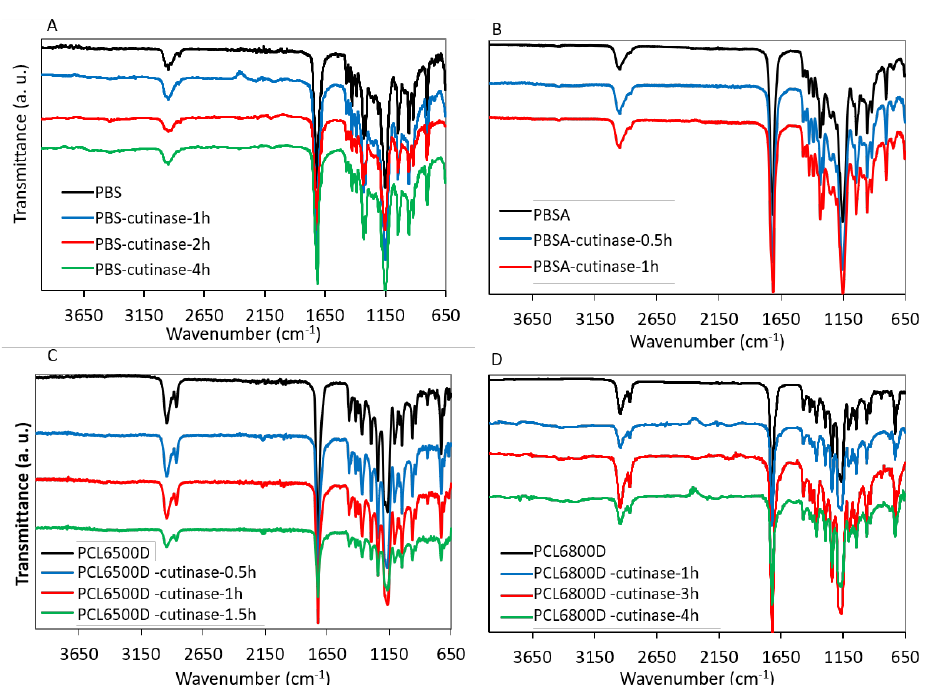
Figure 4. ATR FT-IR curves of PBS ( A ), PBSA ( B ), PCL 6500D ( C ) and PCL 6800D ( D ) residual solids after treatment with cutinase.